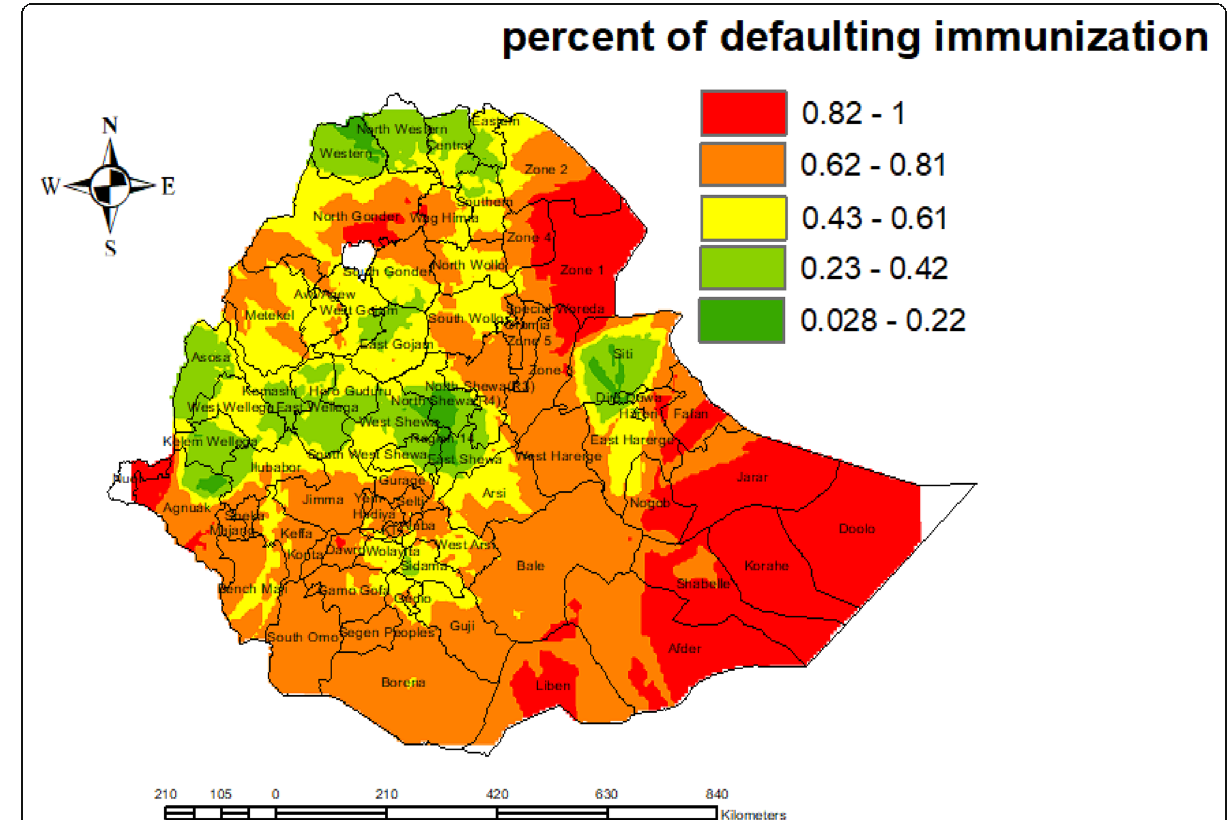
Fig. 5 Interpolation of defaulting from immunization among children aged from 12 to 23 months in EDHS